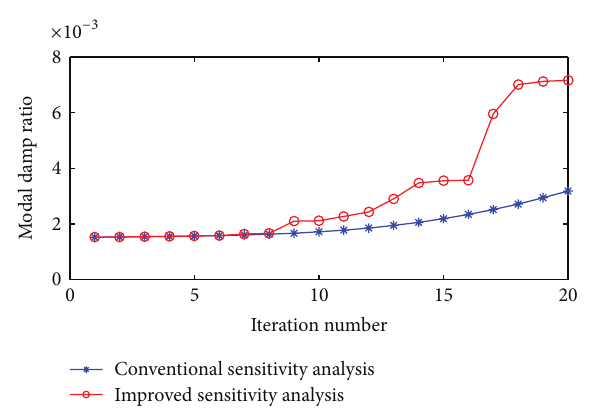
Figure 7: Iteration histories of modal damp ratio.